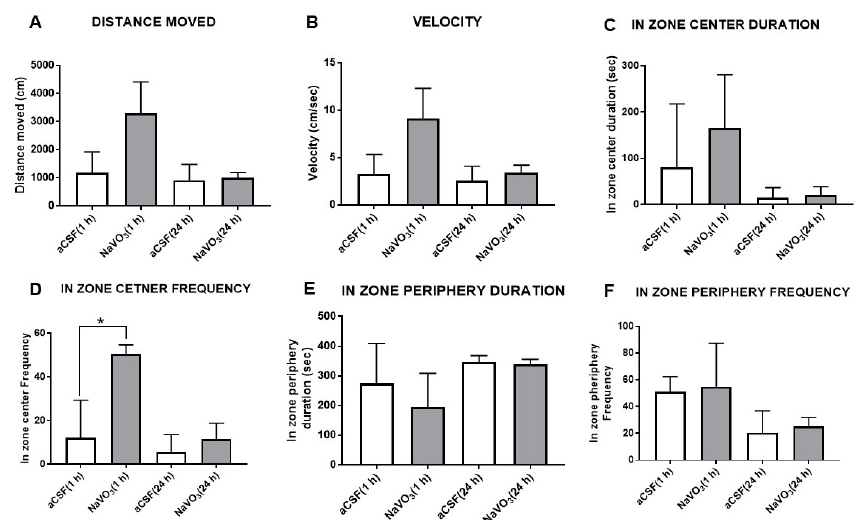
Figure 3. Effect of NaVO 3 on mice behavior in open field test. NaVO 3 was injected (3 μ L from a 10 mM stock solution in aCSF) into the lateral ventricle. OFT was performed as described in Materials and Methods. Distance moved ( A ), velocity ( B ), in-zone duration ( C ), in-zone center frequency ( D ), in-zone periphery duration ( E ), and in-zone periphery frequency ( F ) were recorded with EthoVision XT, video tracking software. (number of mice = 6); * significantly different from mice receiving aCSF, p < 0.05. The effect of NaVO3 on behavior was also tested in the forced swimming test (FST),